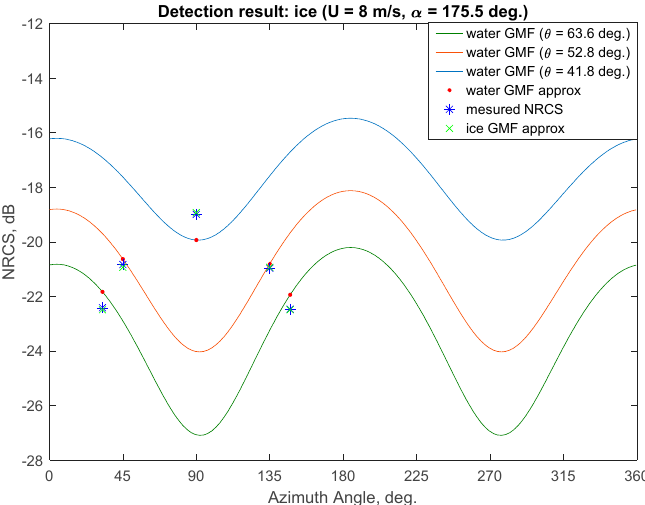
Figure 9. An example of the water GMF approximation from the measured NRCSs, water GMF curves for the incidence angles of 41.8°, 52.8°, and 63.6° and the sea ice GMF approximations.